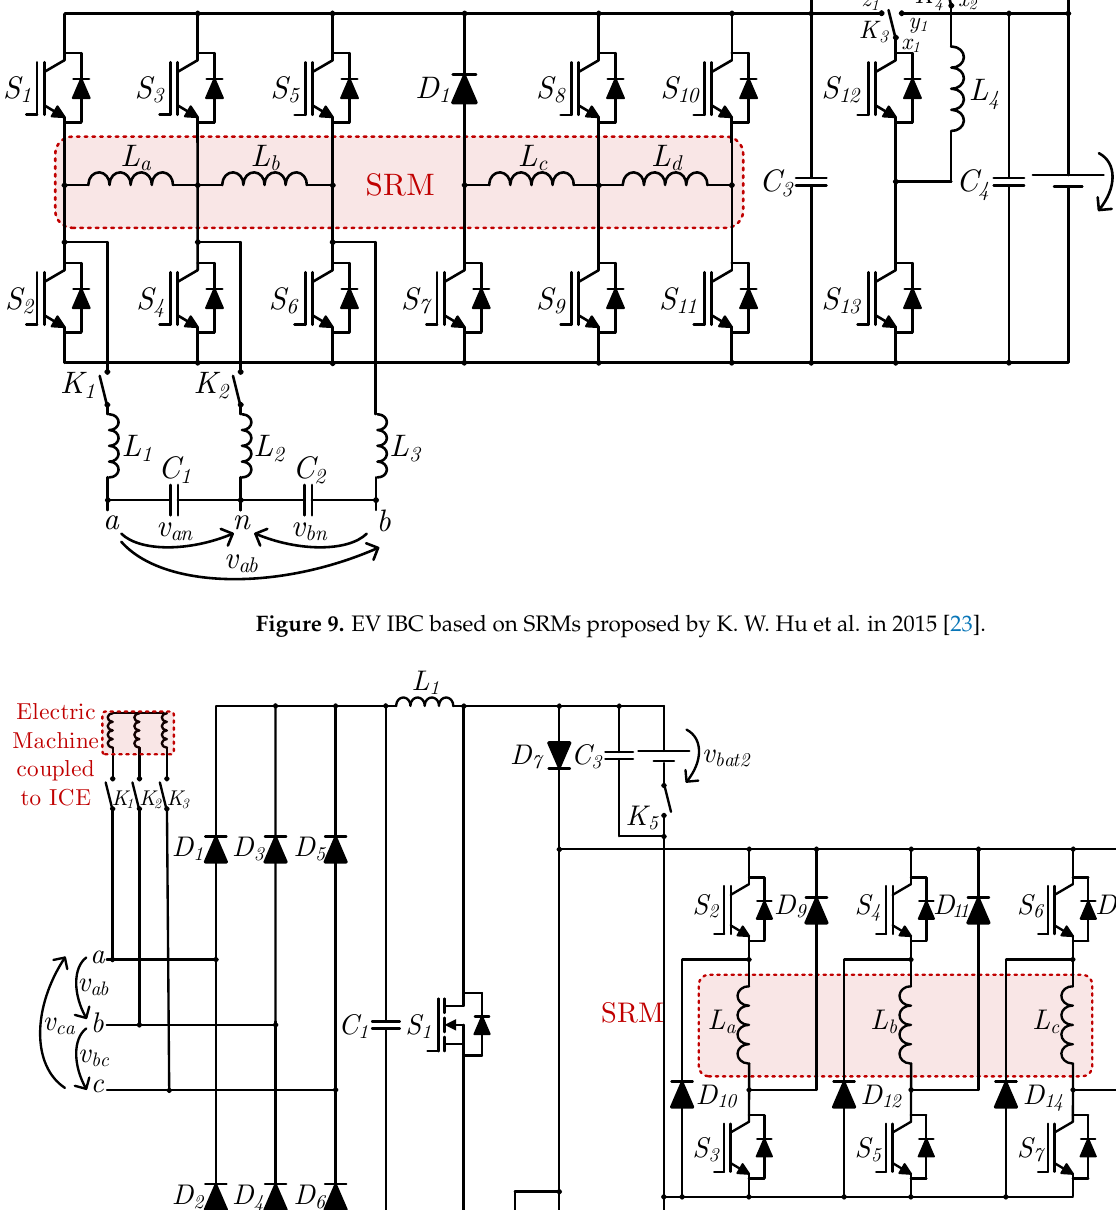
as required in a hybrid vehicle.